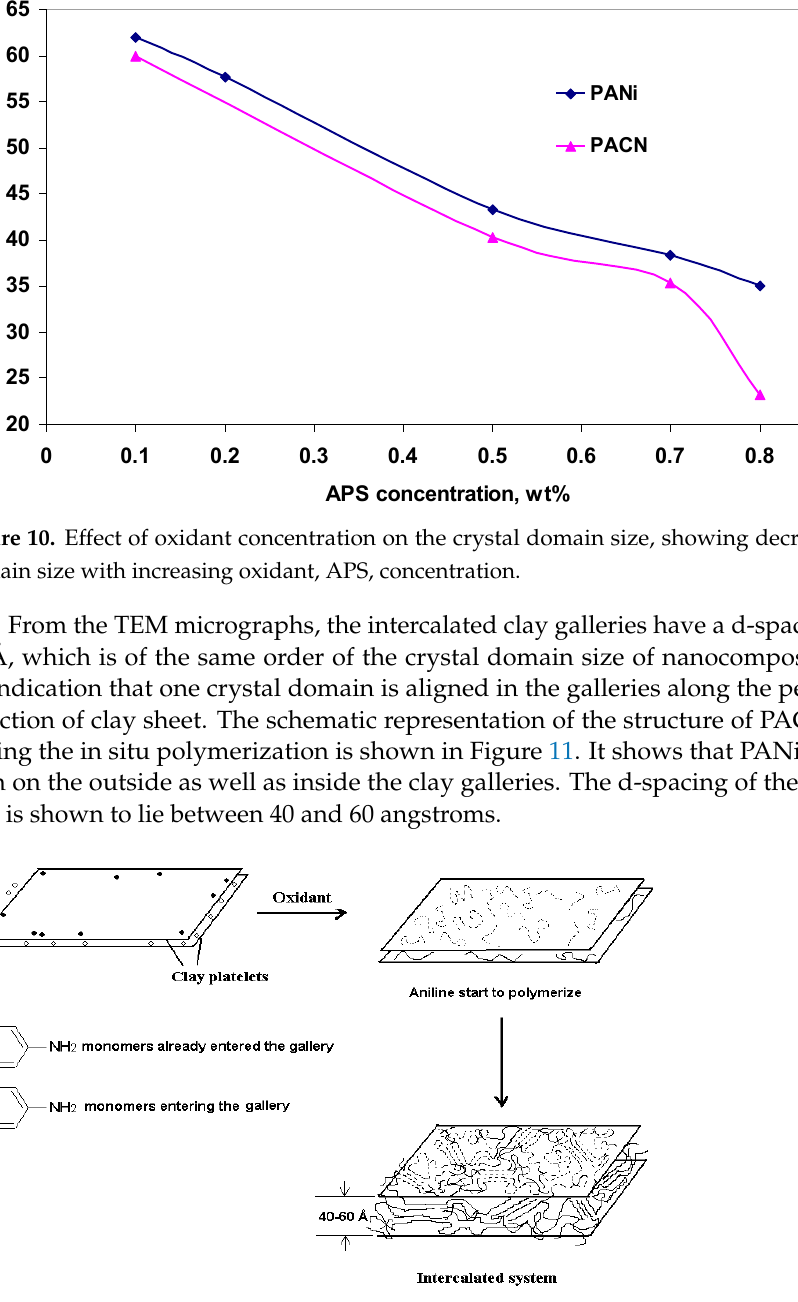
Figure 11. Schematic representation of in situ polymerization of PACN.